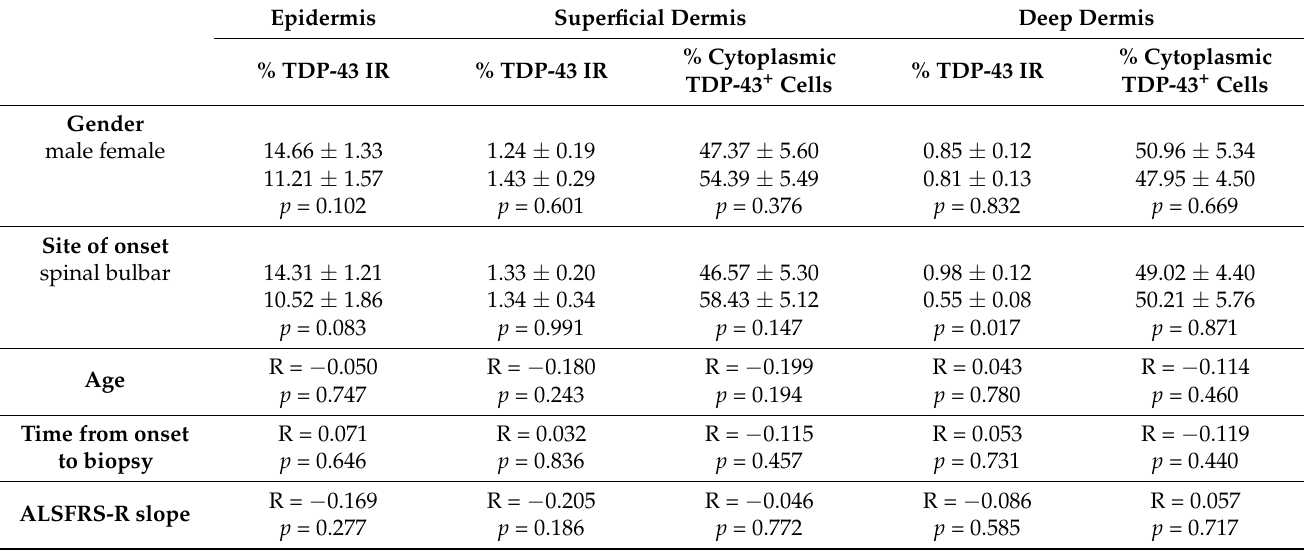
Table 2. TDP-43 quantification and clinical features of ALS patients ( N = 44). IR: immunoreactivity; R: Pearson correlation